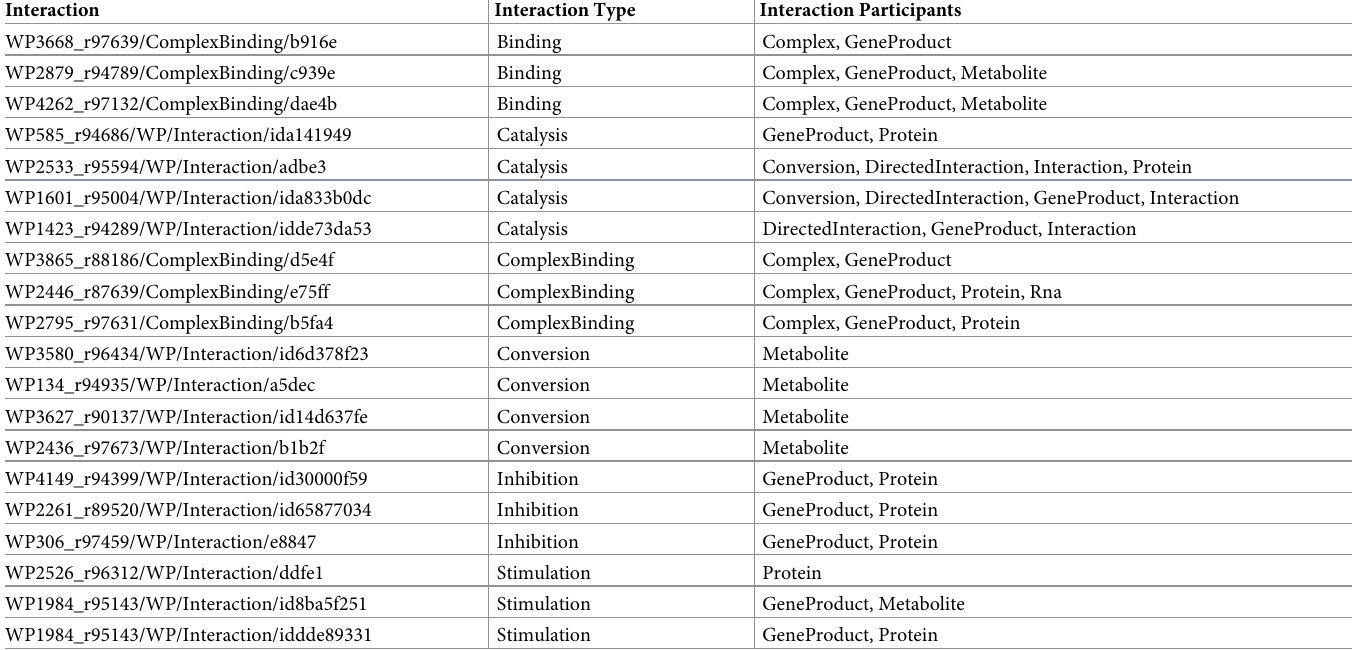
Table 5. Participants for interactions. Twenty example interaction syntaxes shown in table below. First twenty interactions from the WikiPathways RDF along with their interaction type and the participants for each